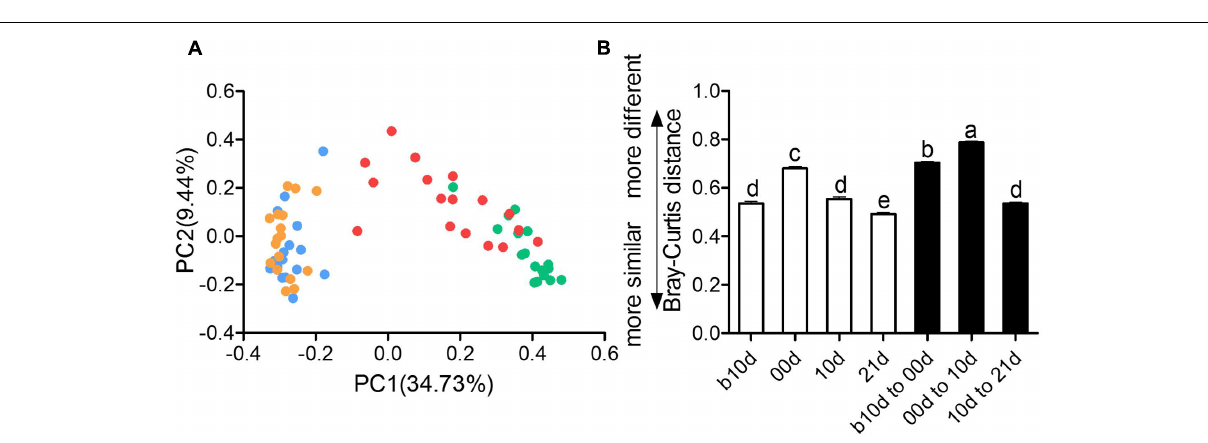
FIGURE 4 | Inter- and intraindividual variations of the gut microbiota of the piglets. (A) Trajectory of the gut microbiota structure of each piglet across age based on Bray–Curtis distance. (B) Interindividual variations were determined by average Bray–Curtis distances between individuals in 10 days before weaned (b10d), weaned day (00d), 10 days after weaned (10d), or 21 days after weaned (21d), respectively, while intraindividual variations were determined by distances between paired b10d and 00d, 00d and 10d, and 10d and 21d samples, respectively. Mean values ± SEM are shown. Different letters above the bar denote significant difference tested by Student’s t -test with 1,000 Monte Carlo